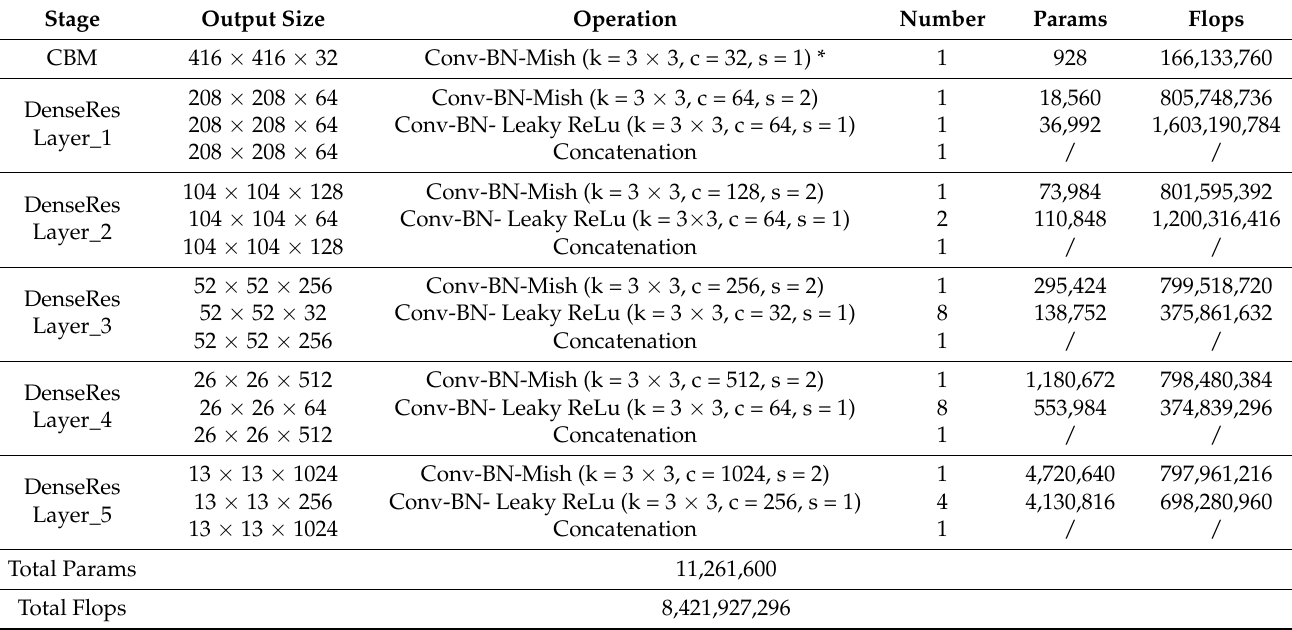
Table A1. The architecture and complexity of